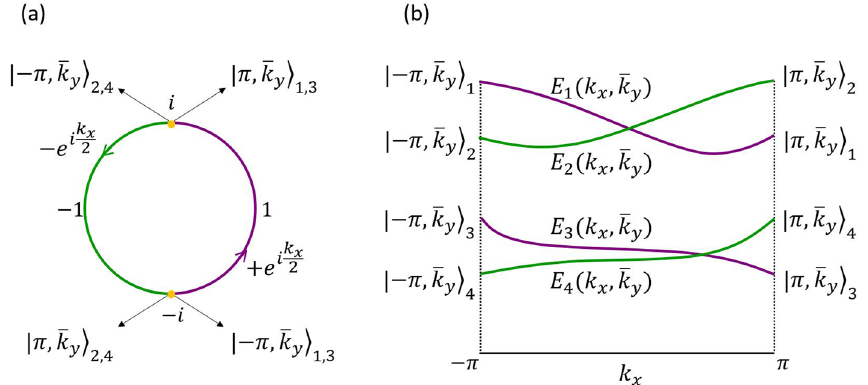
e i kx 2 of the glide-plane matrix winding around the half-unit ± i to i through 1, and the other pair from i to − π , π , k y k y 1,3 and 2,4 associated to the extreme points of the eigenvalue- ¯ ¯ | ± � | ± �